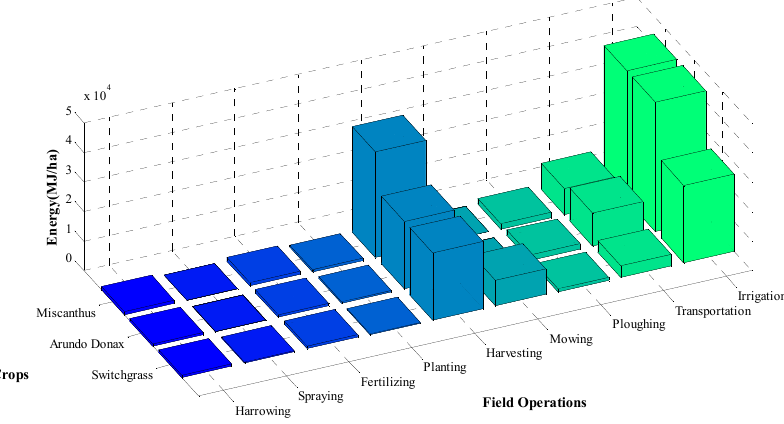
Figure 4. Fuels energy consumption per crop per field operation (for 10 years cycle) (MJ·ha − 1 ).